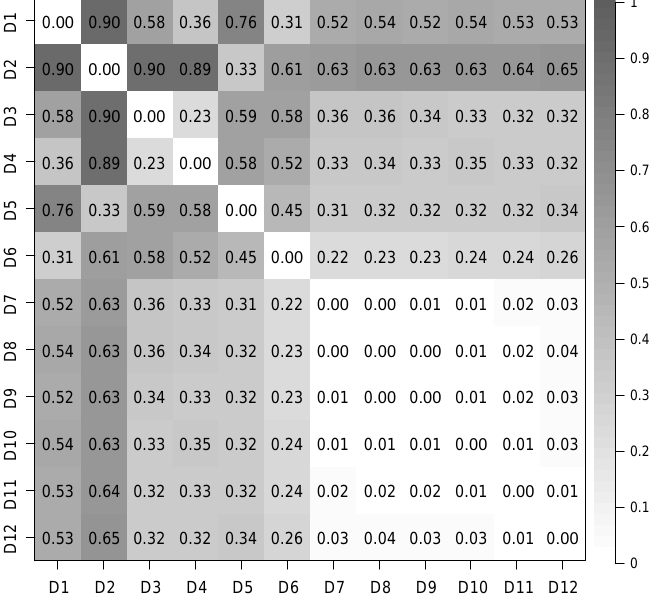
Figure 8. Distance of correlation between each pair of time-series of latent features extracted from the 12 datasets by using